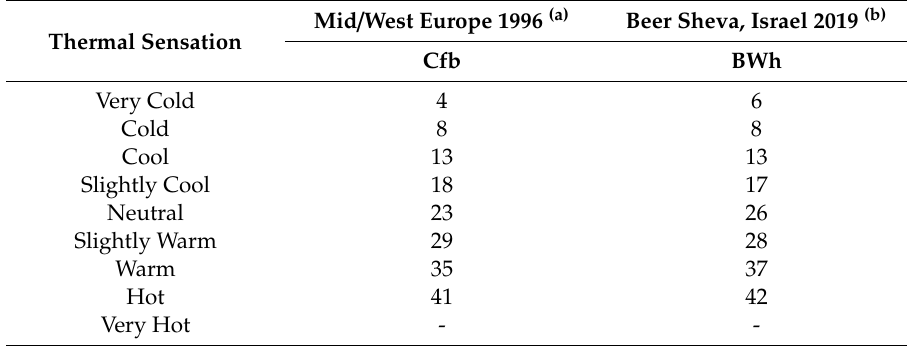
Table 5. The original (Physiologically Equivalent Temperature) PET scale for Middle / Western Europe (Cfb) and the adjusted PET scale for Beer Sheva in Israel (BWh). Sources: (a) [19], (b)